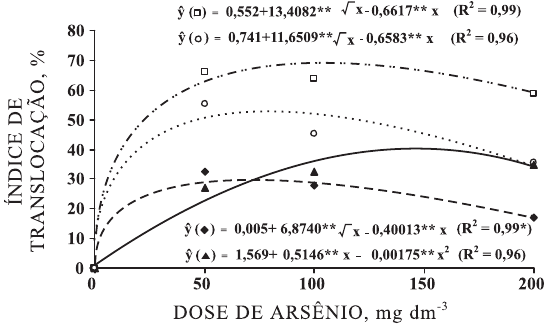
Figura 5. Índice de translocação de arsênio em plantas de aveia ( ), azevém ( ), amendoim ( ) e estilosante ( ) cultivadas em amostras de um LVA de João Pinheiro-MG em solos com diferentes doses de As. **: significativo a 1 % pelo teste